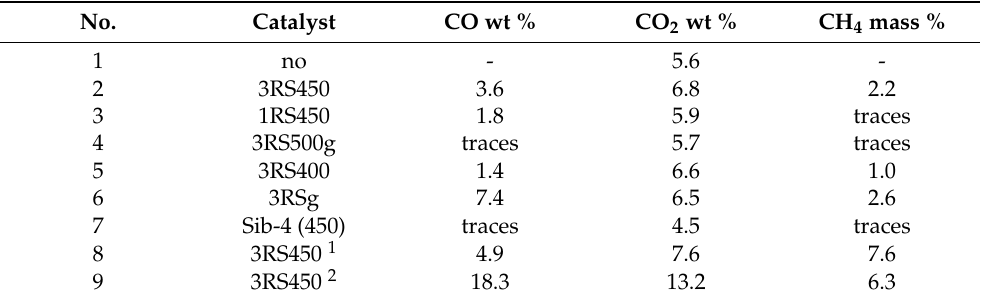
Table 5. Yield and composition of the gaseous products of hydrogenolysis of flax shive. No. Catalyst